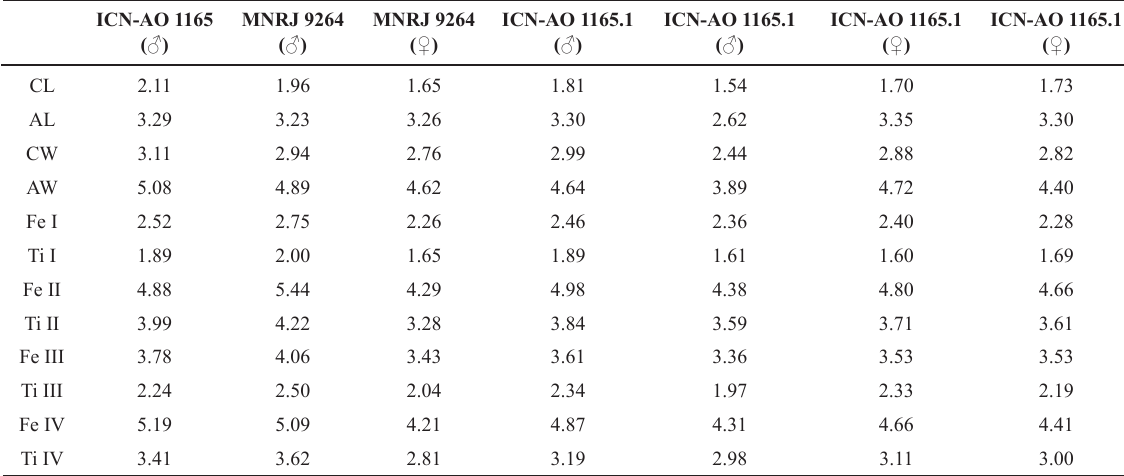
Table 2. Measurements of body and appendages of Eulibitia leda sp. nov. ICN-AO 1165